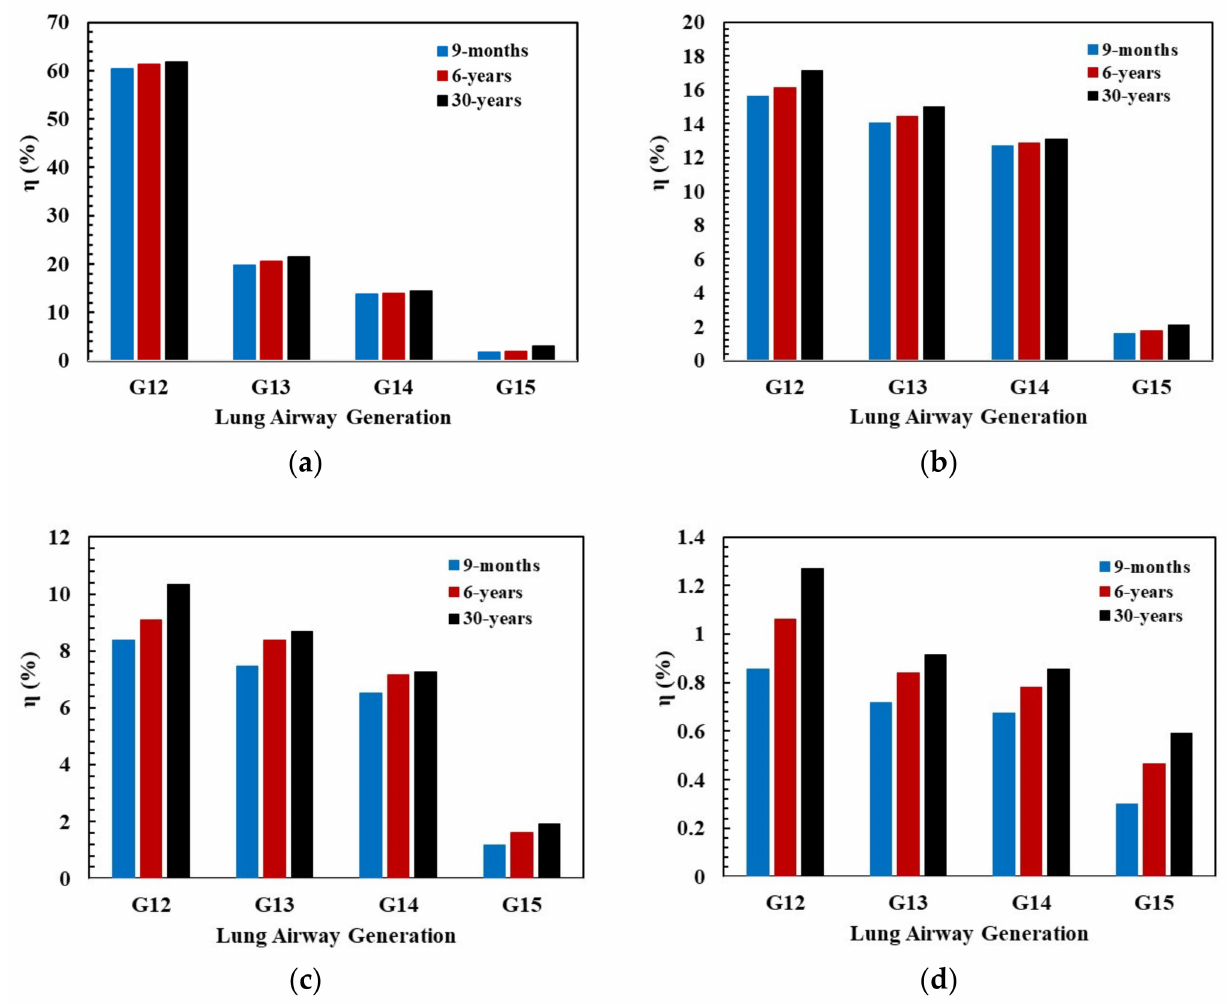
Figure 11. Different size particle deposition efficiencies at lower airways generation (G12–G15) of the lung are defined in Figure 1. ( a ) d p = 5 nm, ( b ) d p = 50 nm, ( c ) d p = 100 nm, and ( d ) d p = 500